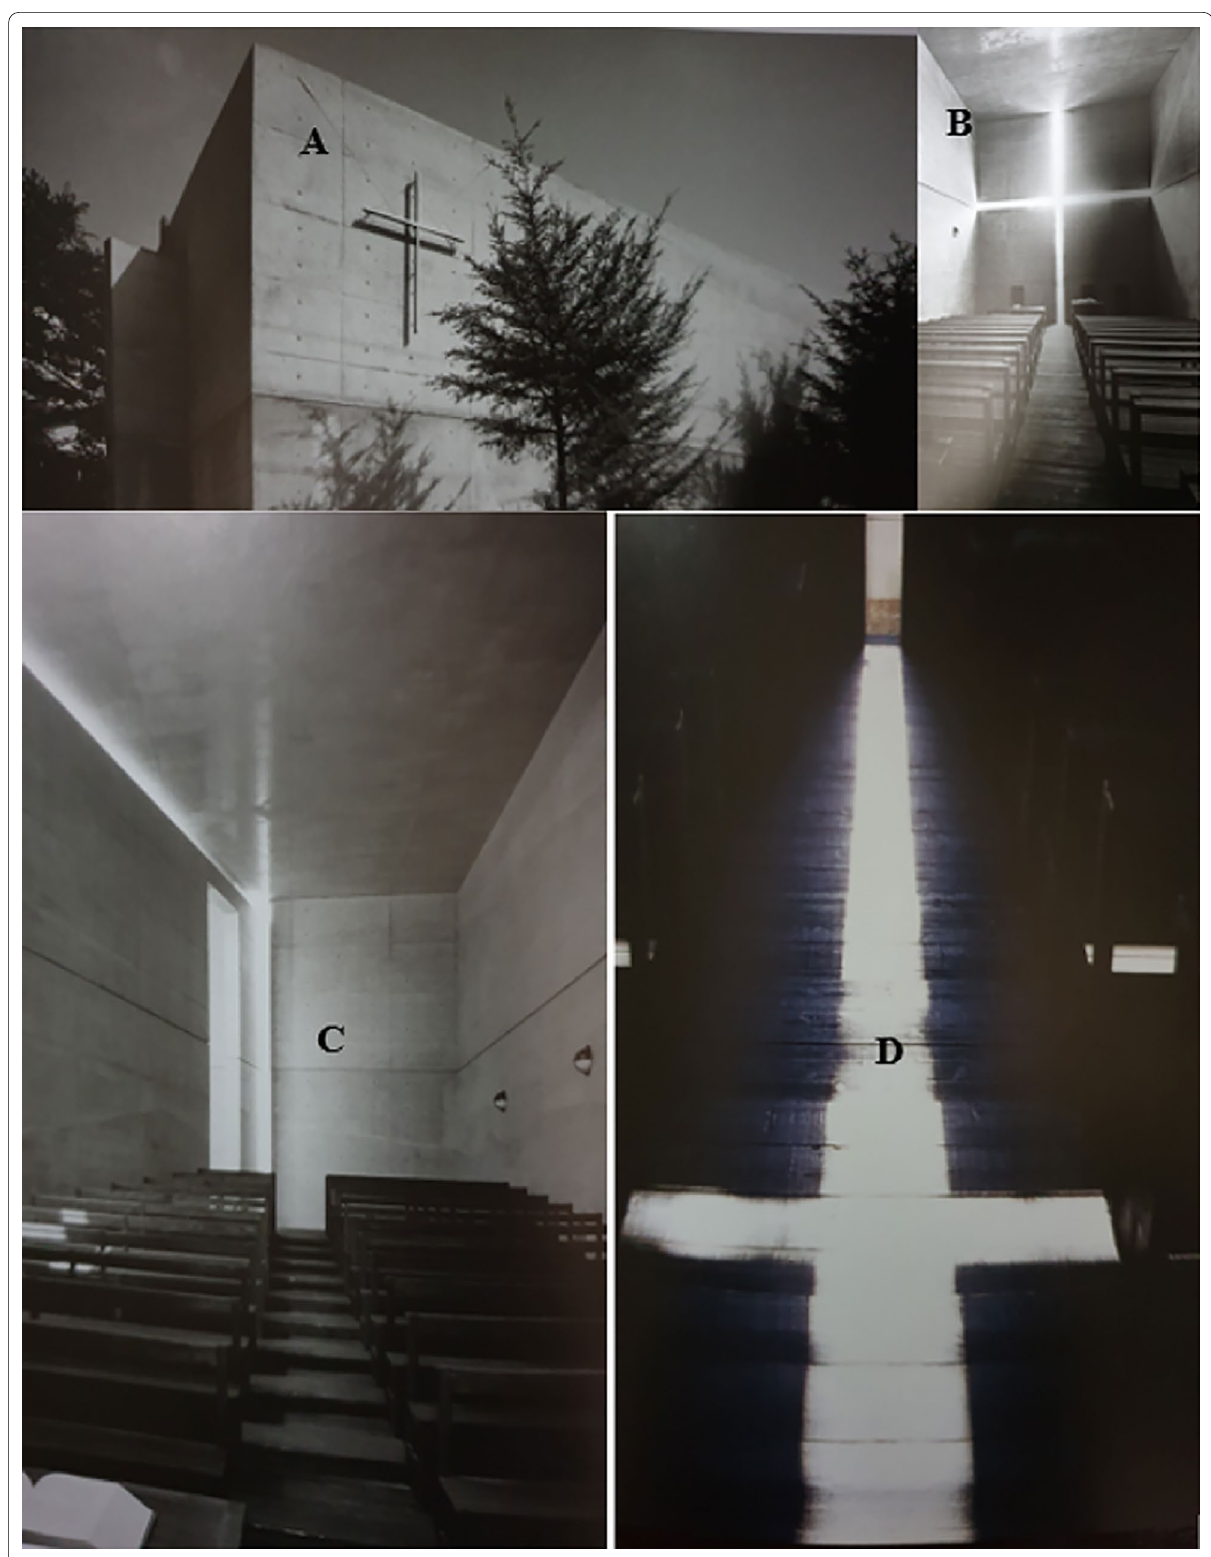
Fig. 4 Church of the Light, Irabaki, Osaka, Japan ( Source: Tadao Ando: Complete Works 1975–2012 (Jodidio